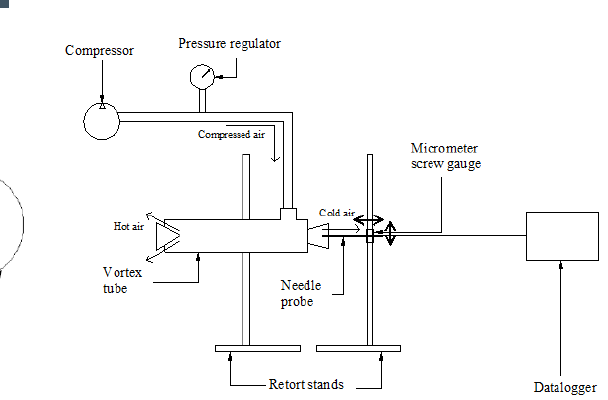
Figure 3. Schematic diagram of the experimental setup.